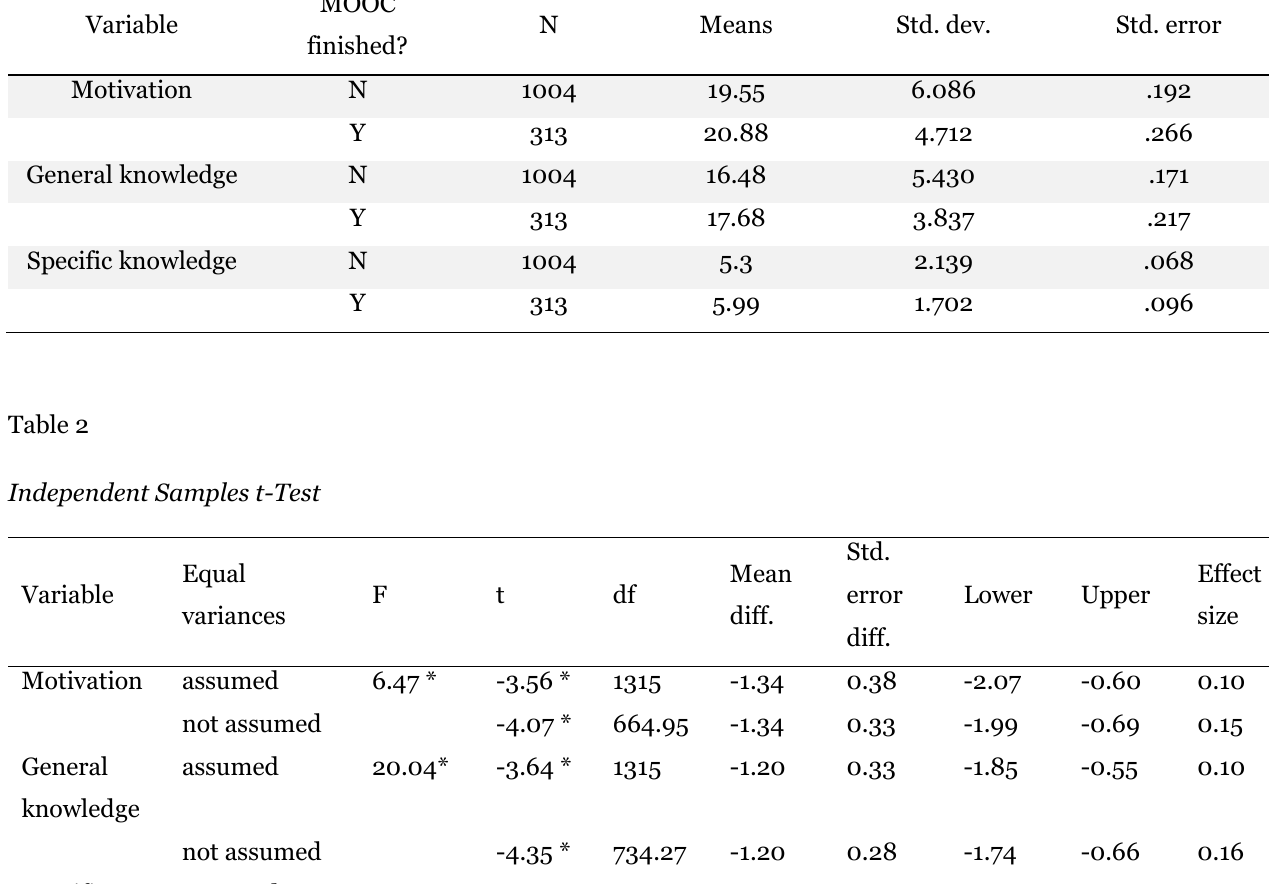
Means by Group Variable